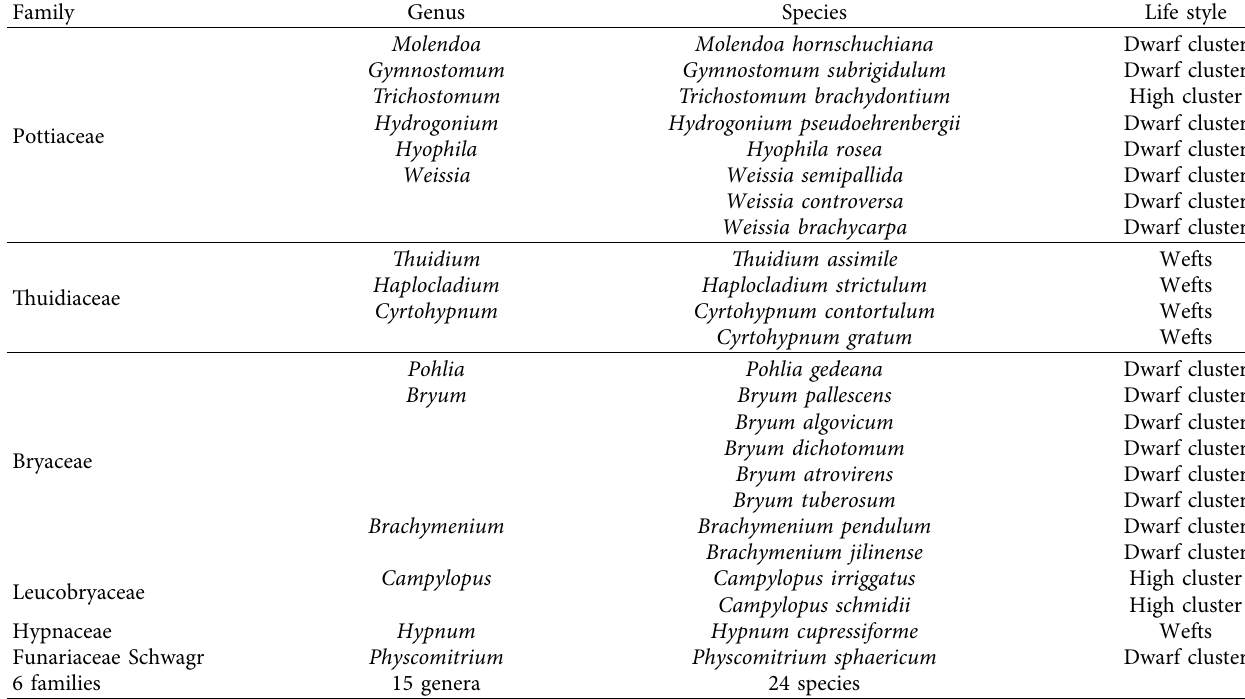
Table 3: Statistics of bryophytes, genera, and species in mine waste slag areas.